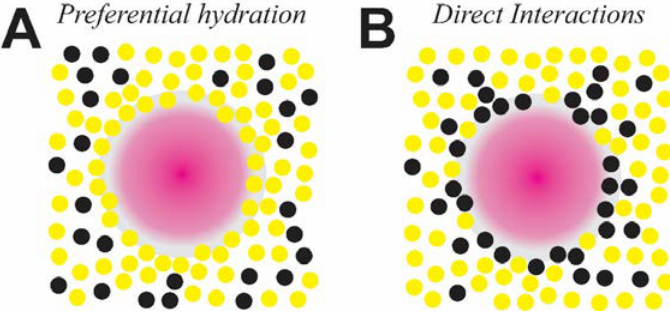
Figure 5. Schematic representations of the effects of the small organic molecules (black) and solvent molecules (yellow) on mineral precursors (pink), indicating ( A ) a preferential hydration of mineral co-solutes and ( B ) direct organic-inorganic interactions.